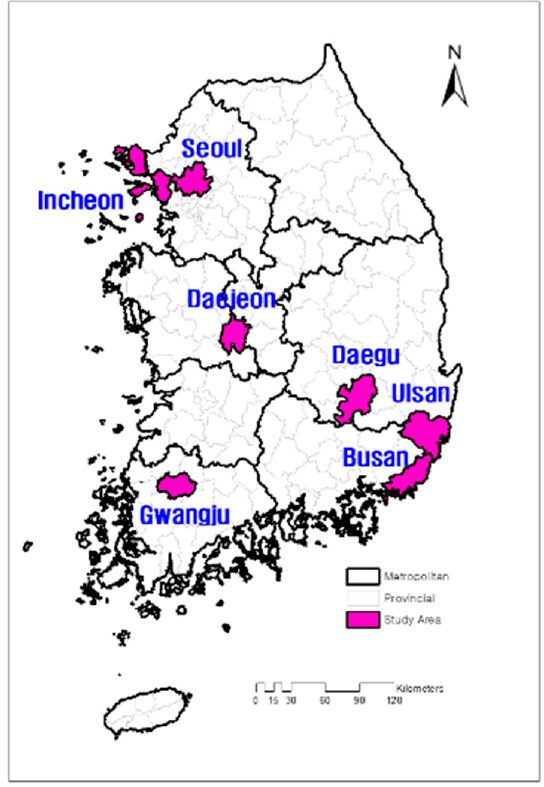
Figure 1. Target Figure 1. Target regions.